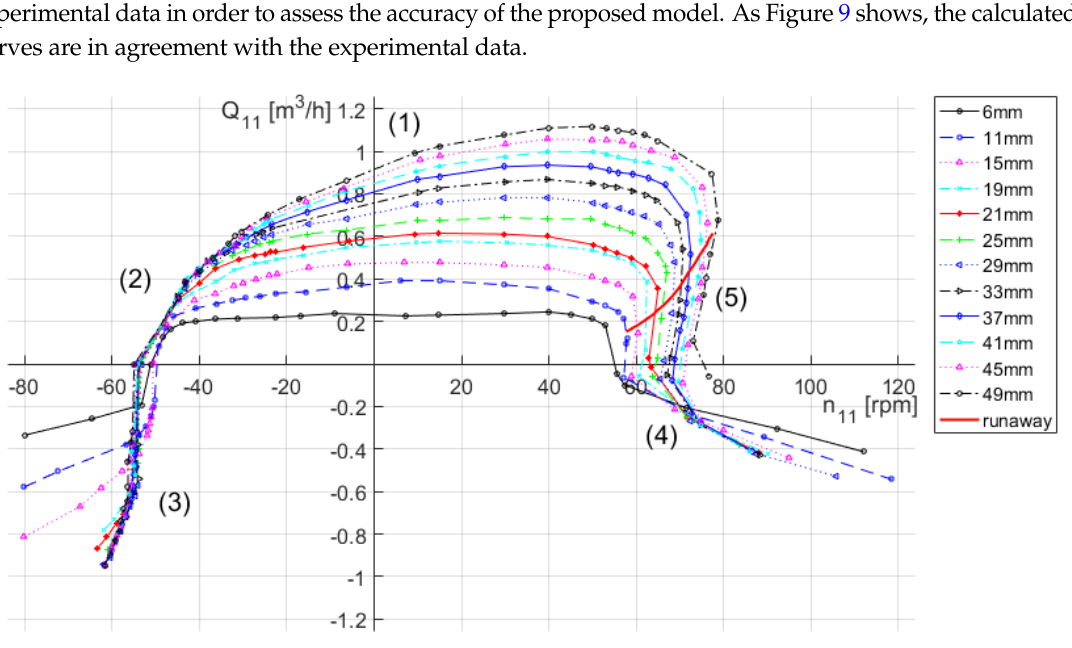
Figure 8. Experimental characteristic curves of the machine (from the report of test in Xiangshuijian pumped storage plant [15]) for different values of openings: (1) turbine mode; (2) and (5) braking mode; (3) pump mode; and (4) reverse pump mode.